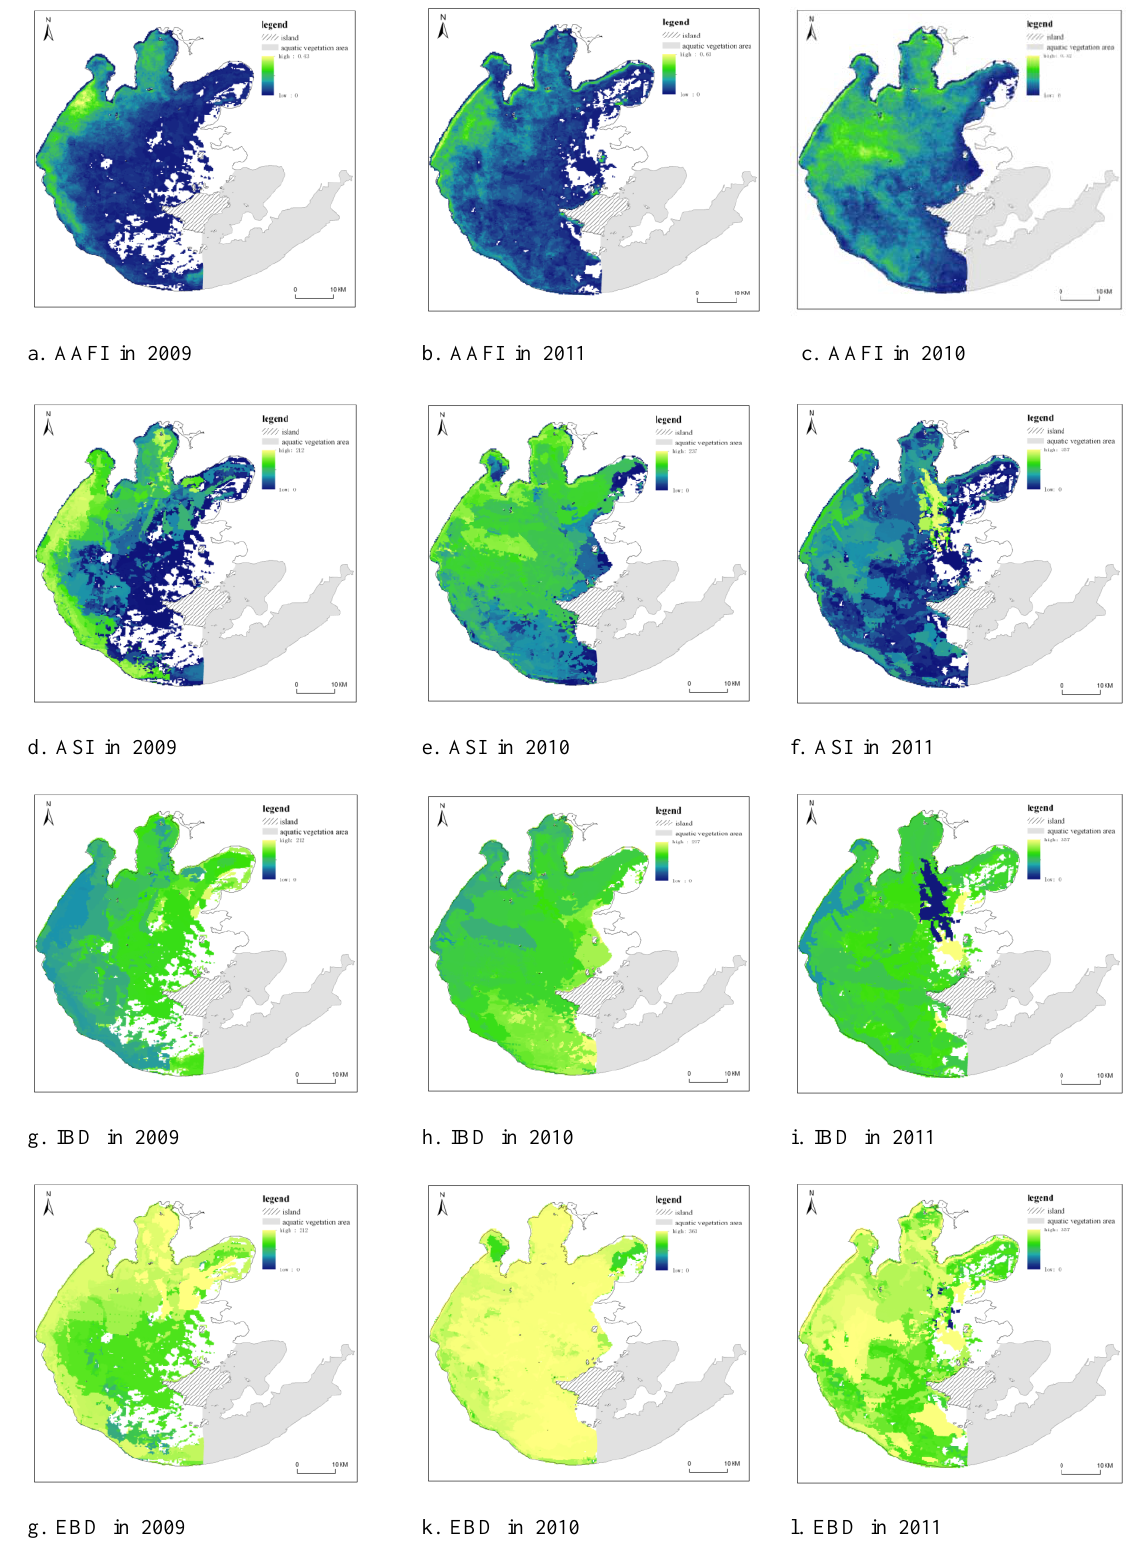
Figure 2 the spatial distribution patterns of the annual algae bloom frequency index, algae bloom sustainability index, annual initial blooming date and end blooming date in 2009, 2010 and 2011 The algae bloom sustainability index (ASI) is defined as the region adding one. The first days which is a effective difference between the last days and the first days at a monitoring day to find algae bloom at a certain time is called certain time to find algae bloom using NDVI in certain water as initial blooming date (IBD) in certain water region.